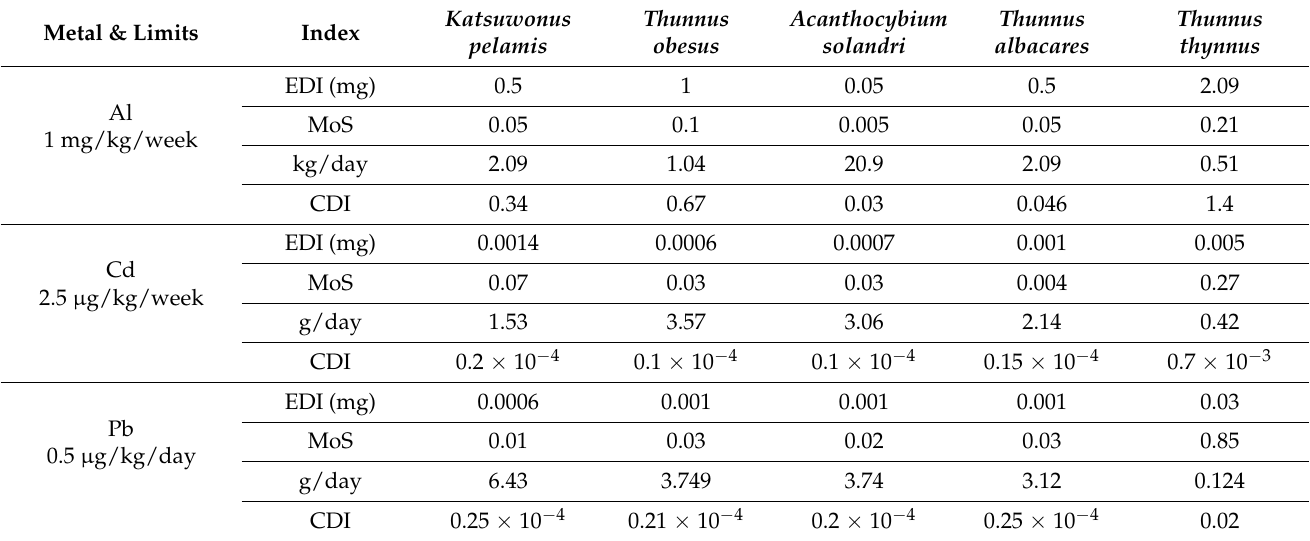
Table 6. Heavy metal risk assessment for the species studied in